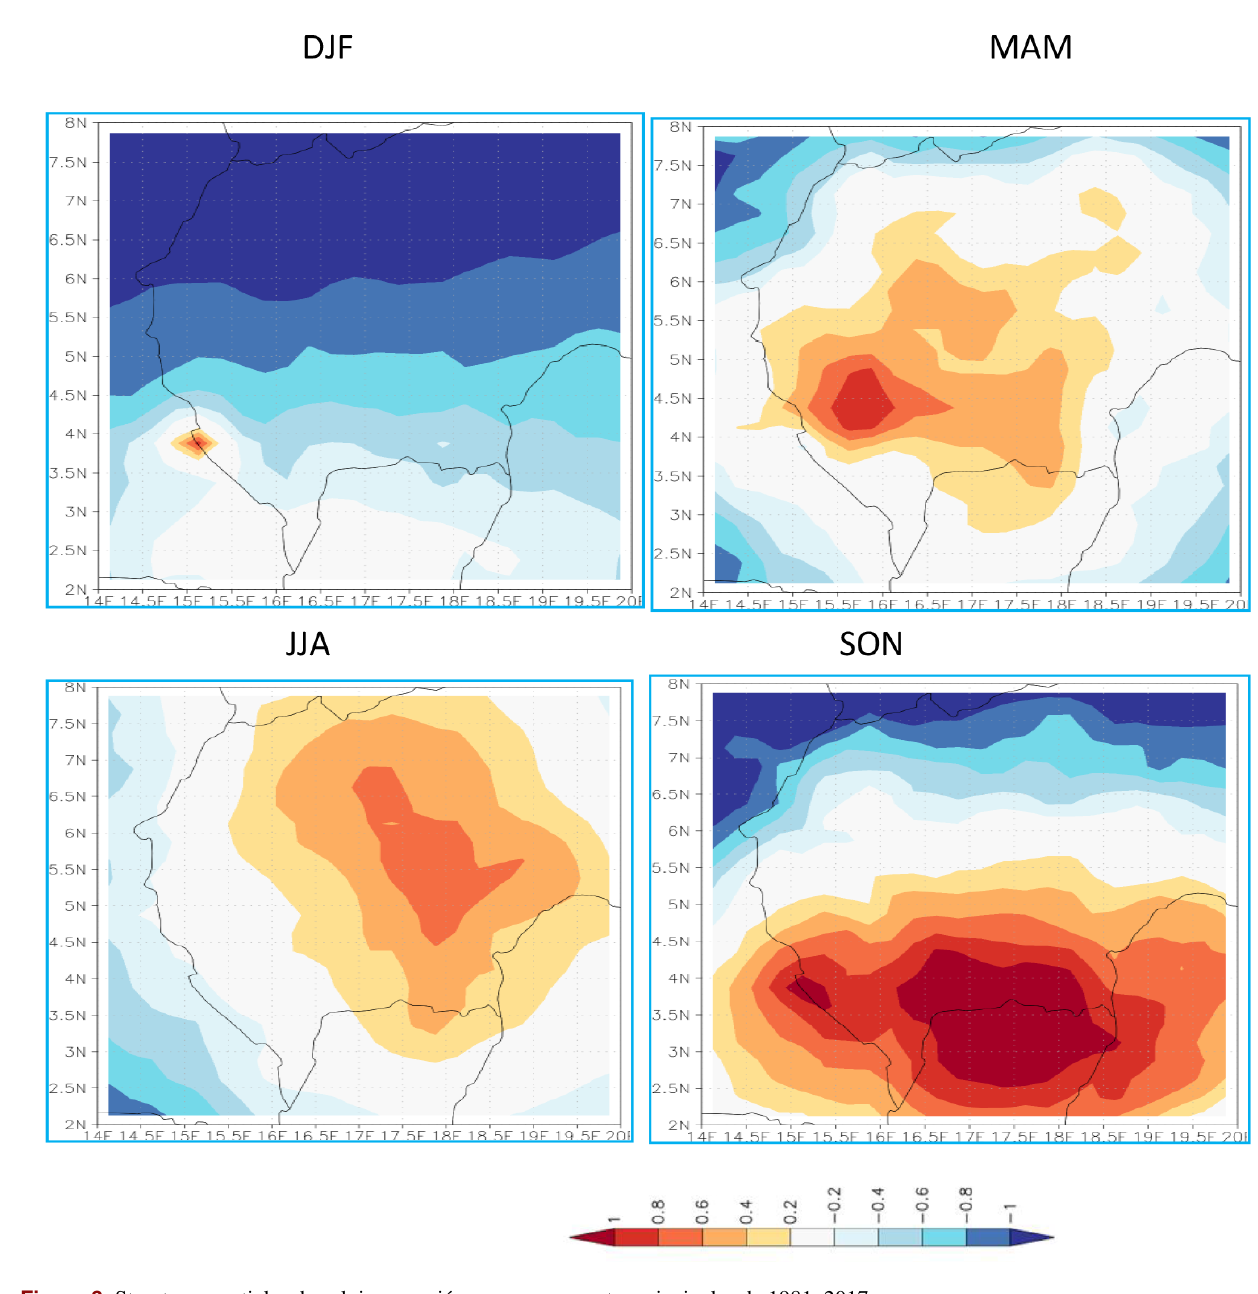
Figure 3. Structures spatiales des pluies associées aux composantes principales de